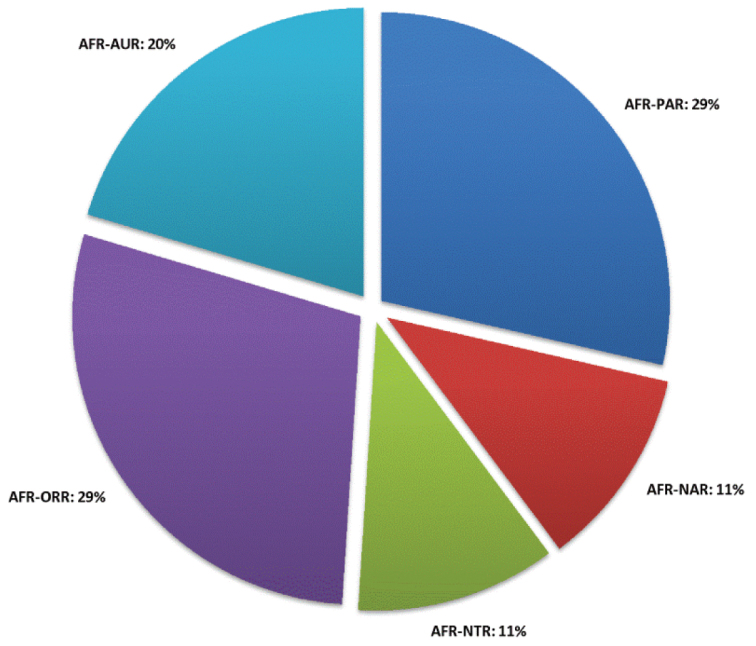
Percentage of flea beetle genera co-occuring in the Afrotropical and another zoogeographical region (AFR: Afrotropical; AUR: Australian; ORR: Oriental; NAR: Nearctic; NTR: Neotropical; PAR: Palaearctic) (updated from Biondi and D’Alessandro 2010a).